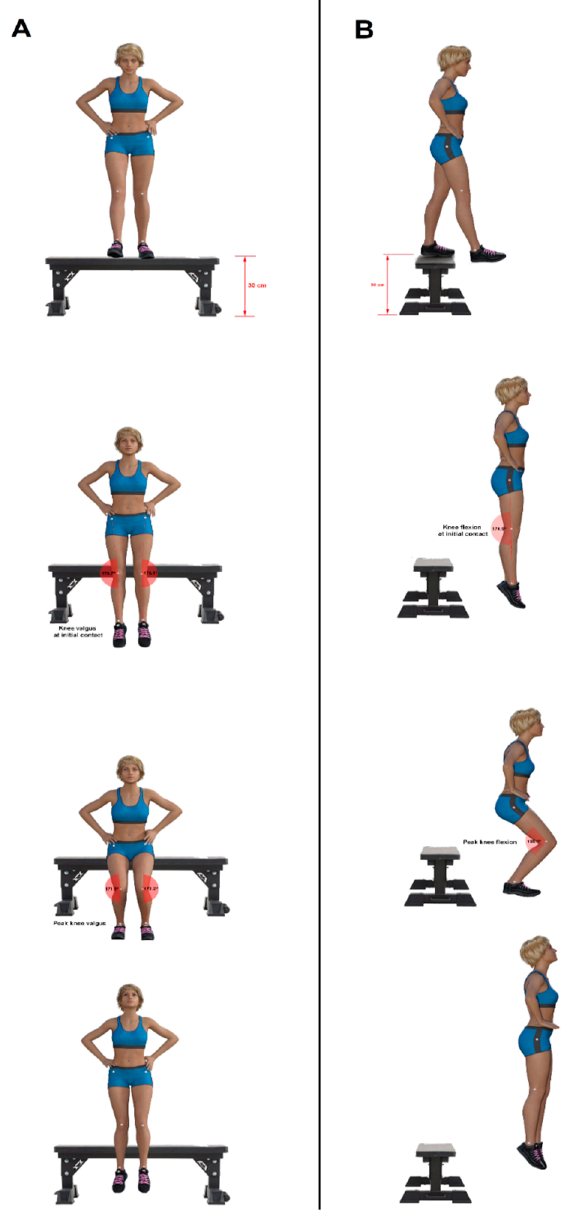
Figure 2. Drop jump measurement. ( A ): frontal plane analysis; ( B ): sagittal plane analysis.